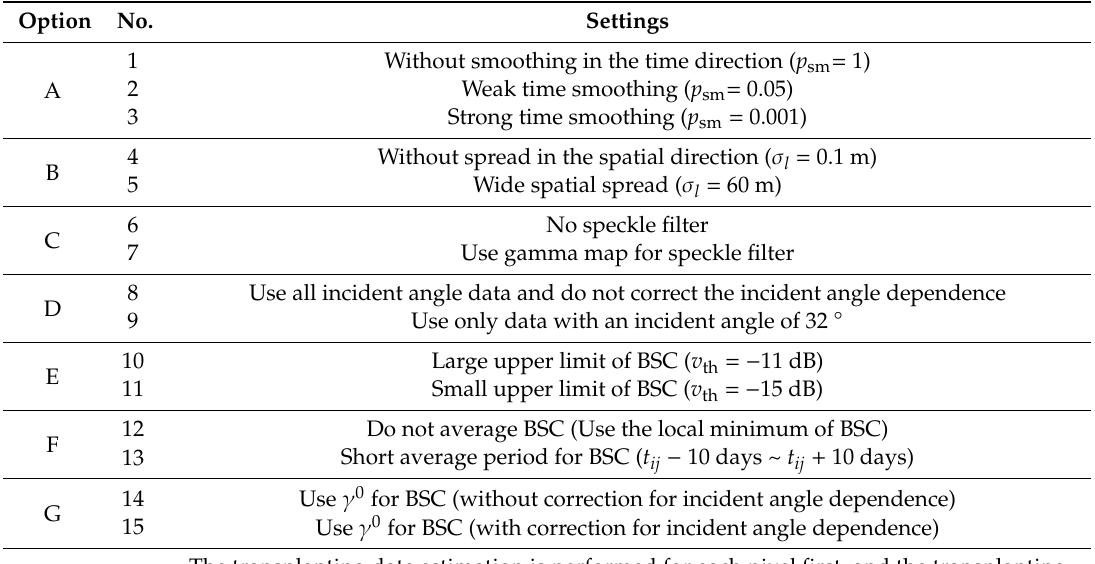
Table 3. Condition settings for the optimization of the transplanting date estimation